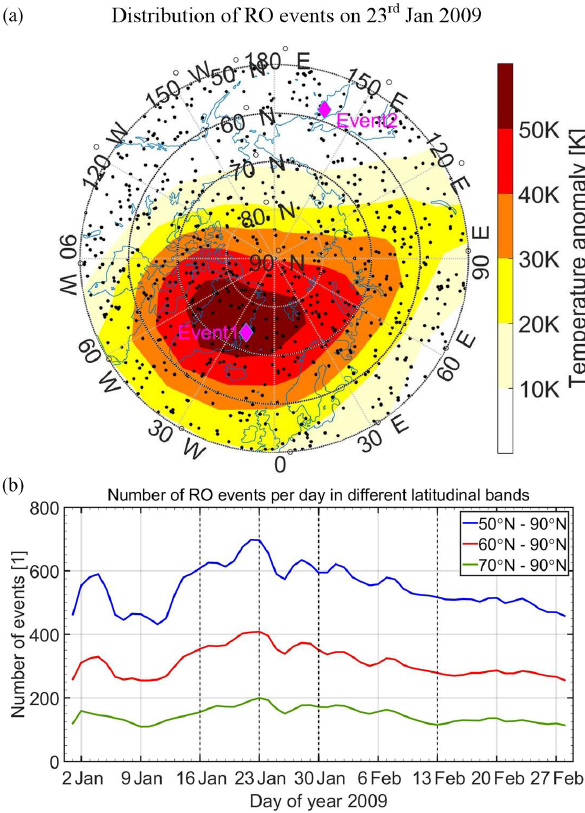
Figure 1. Illustrative distribution of RO event locations on 23 Jan- uary 2009 (black dots), overplotted on the middle-stratosphere tem- perature anomaly of the day (a) , and number of RO events per day in the latitudinal bands of 50–90 ◦ N (blue), 60–90 ◦ N (red), and 70–90 ◦ N (green), during January and February of 2009 (b) . In (a) , “Event 1” represents an RO event with a large temperature anomaly, and “Event 2” one with small anomaly (diamond symbols), as used in the subsequent Figs. 2 and